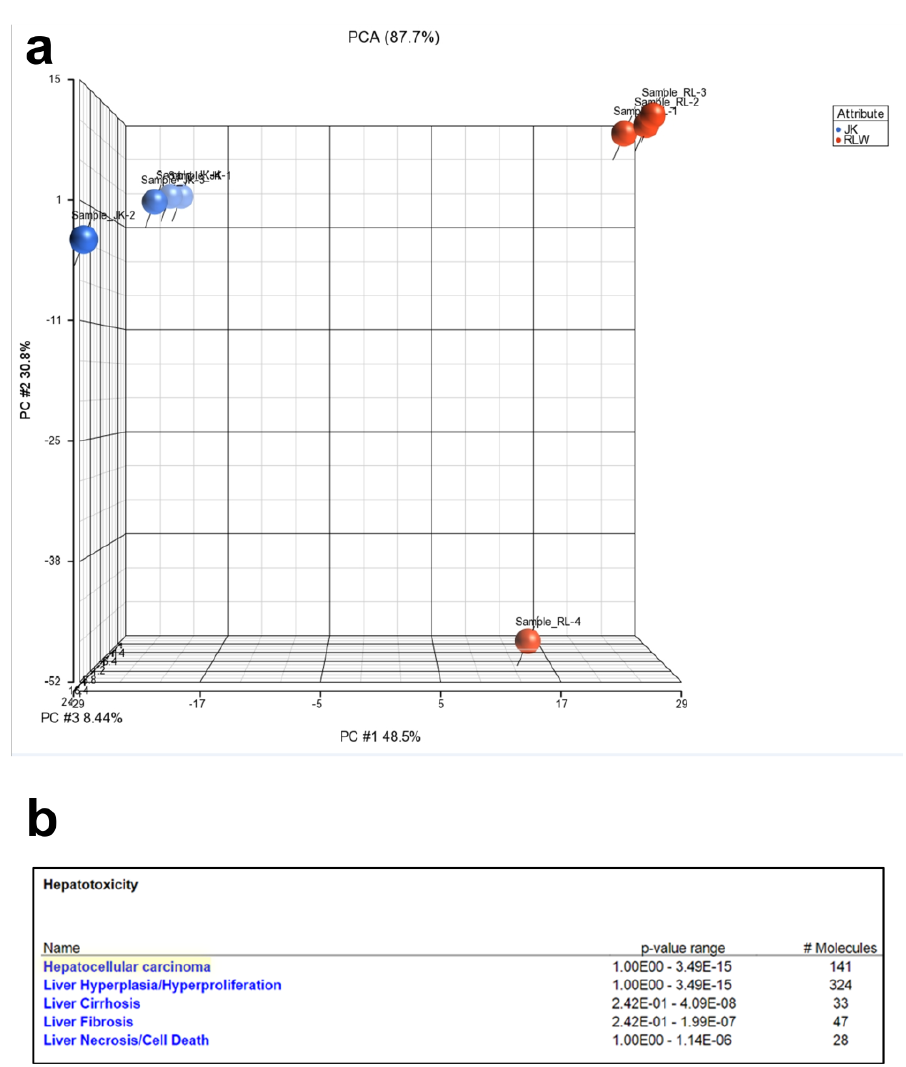
Figure 3. Protein profile of lymphocyte ABs versus hepatocyte ABs analyzed by mass spectrometry. ( a ) Principal component analysis of all analyzed proteins showed that hepatocyte ABs are distinct from lymphocyte ABs. Orange pins represent RLW-derived ABs, and blue pins represent Jurkat cell-derived Abs. ( b ) Ingenuity pathway analysis identified proteins, which are significantly associated with hepatoxicity ( p < 0.05). # indicate number. Data were generated from 4 independent experiments